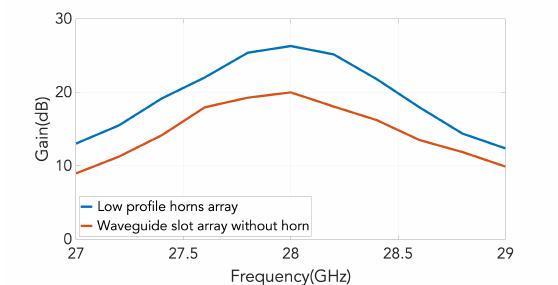
Figure 18. Measured gains of the manufactured 2D transverse waveguide slot array with and without